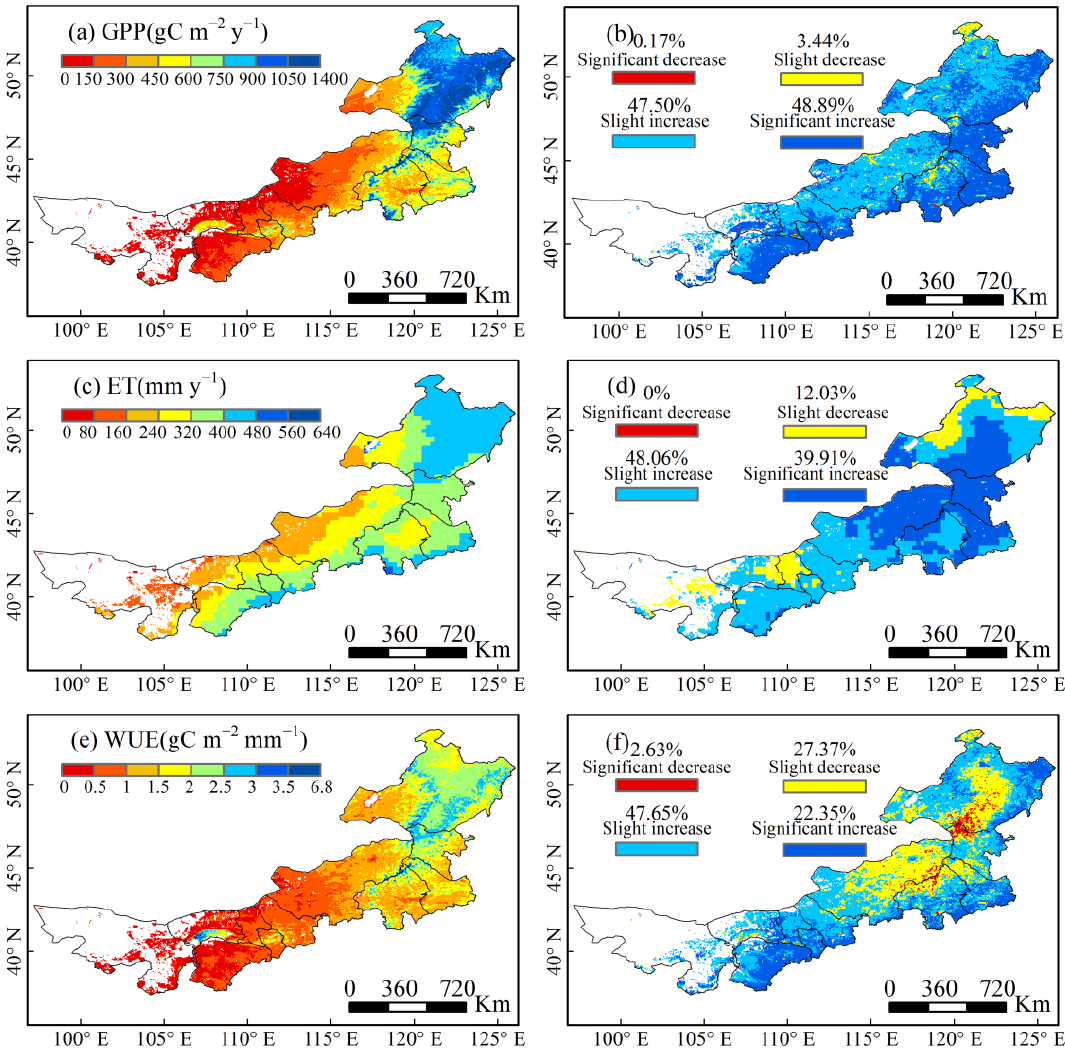
Figure 3. Spatial differences of annual average ( a ) GPP, ( c ) ET, ( e ) WUE, and ( b , d , f ) their trends (significance levels of 0.05) in Inner Mongolia from 2001 to 2020.